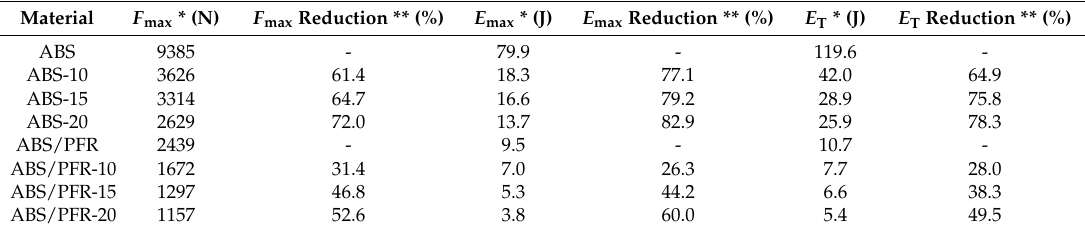
Table 2. Falling weight impact results of unfoamed and foamed ABS and ABS/PFR parts Material